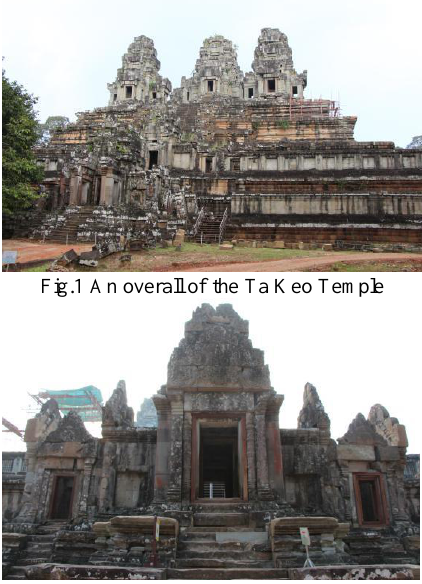
Fig.2 The east gate of the Ta Keo Temple